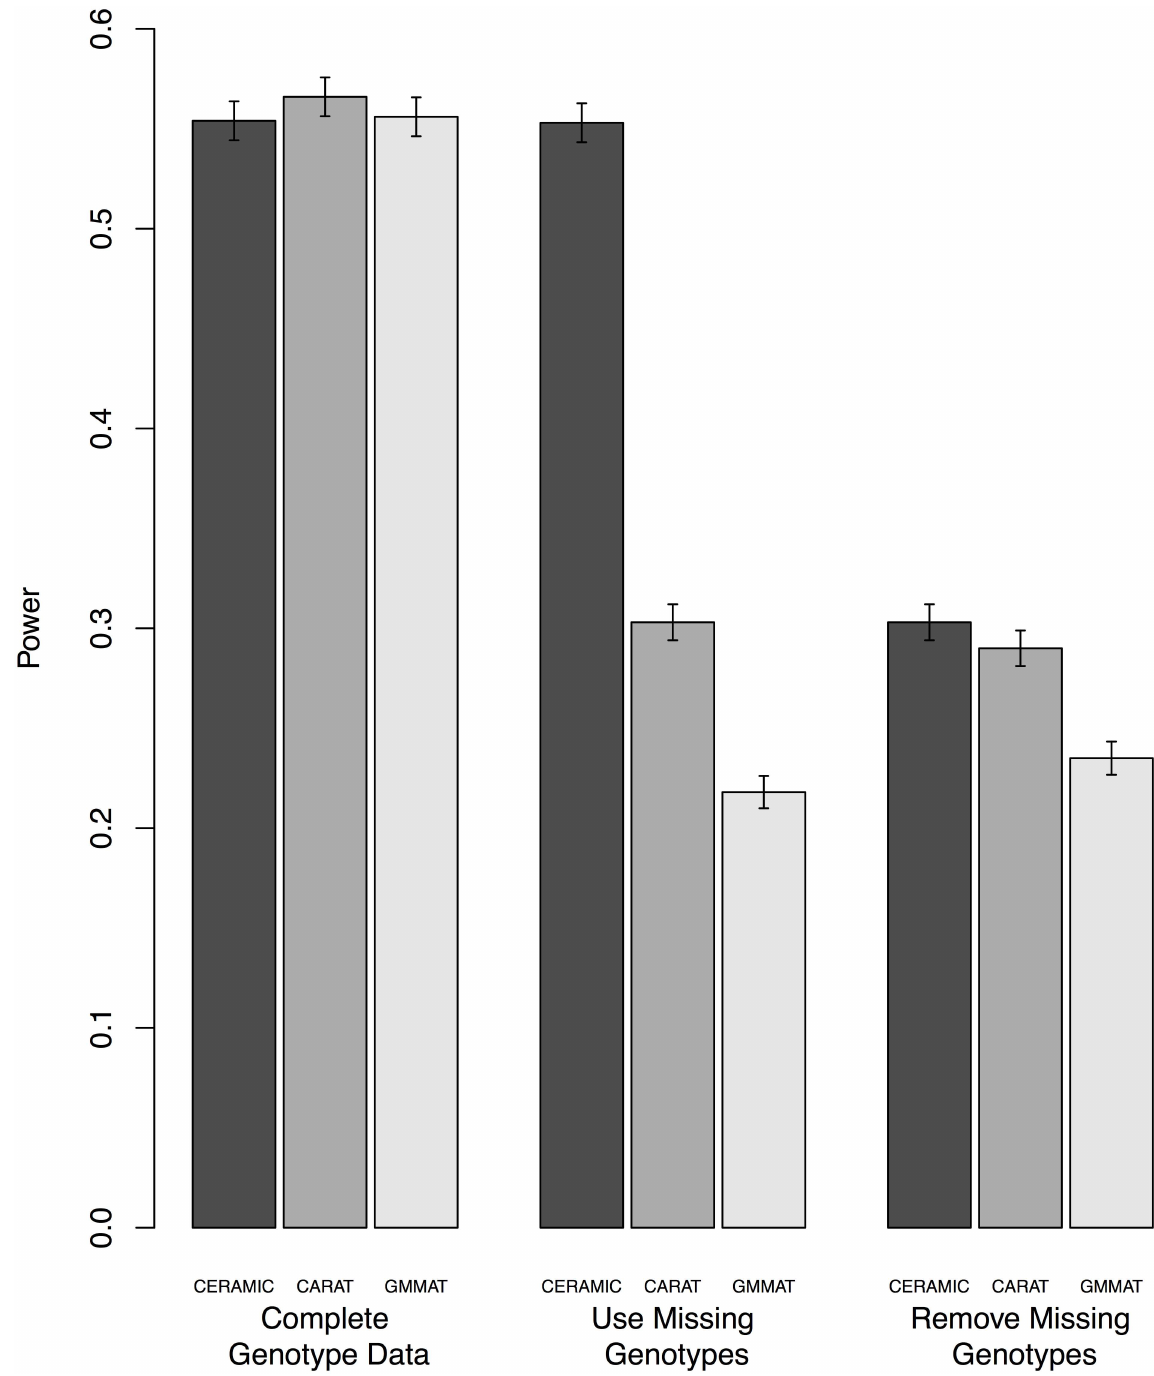
Fig 3. Comparison of Extent of Power Recovery with Missing Genotypes for CERAMIC, CARAT and GMMAT. Empirical power is based on 10,000 replicates. The error bars indicate 95% confidenceintervals. The trait is simulatedaccordingto the liability threshold trait model with ( π a , π b ) = (40; 40) with 1,200 individualsin each simulated replicate, under acertainment setting A with missing data. In the “Remove Missing Genotypes” setting, individualswith missing genotypesare removed from the input files before the methods are run. In the “Use Missing Genotypes” setting, individuals with missing genotypesremain in the input files, and GMMAT is run with the option to impute the mean genotype value for the missing genotypes, CERAMIC is run with default settings, and CARAT is run with the mean genotypevalue pluggedin for the missing genotypesin the input file. In the “CompleteGenotype Data” setting, the missing genotype values are “unmasked” and includedin the input files for all methods.